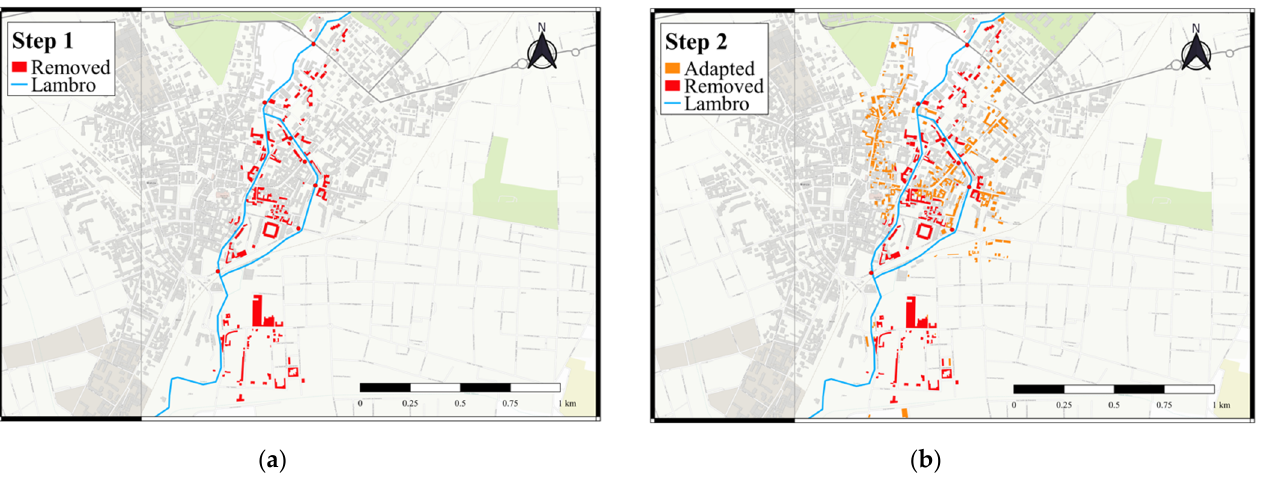
Figure 11. Map of buildings impacted in the river scenario at T = 100 years: ( a ) directly impacted (step 1); ( b ) indirectly impacted (step 2).